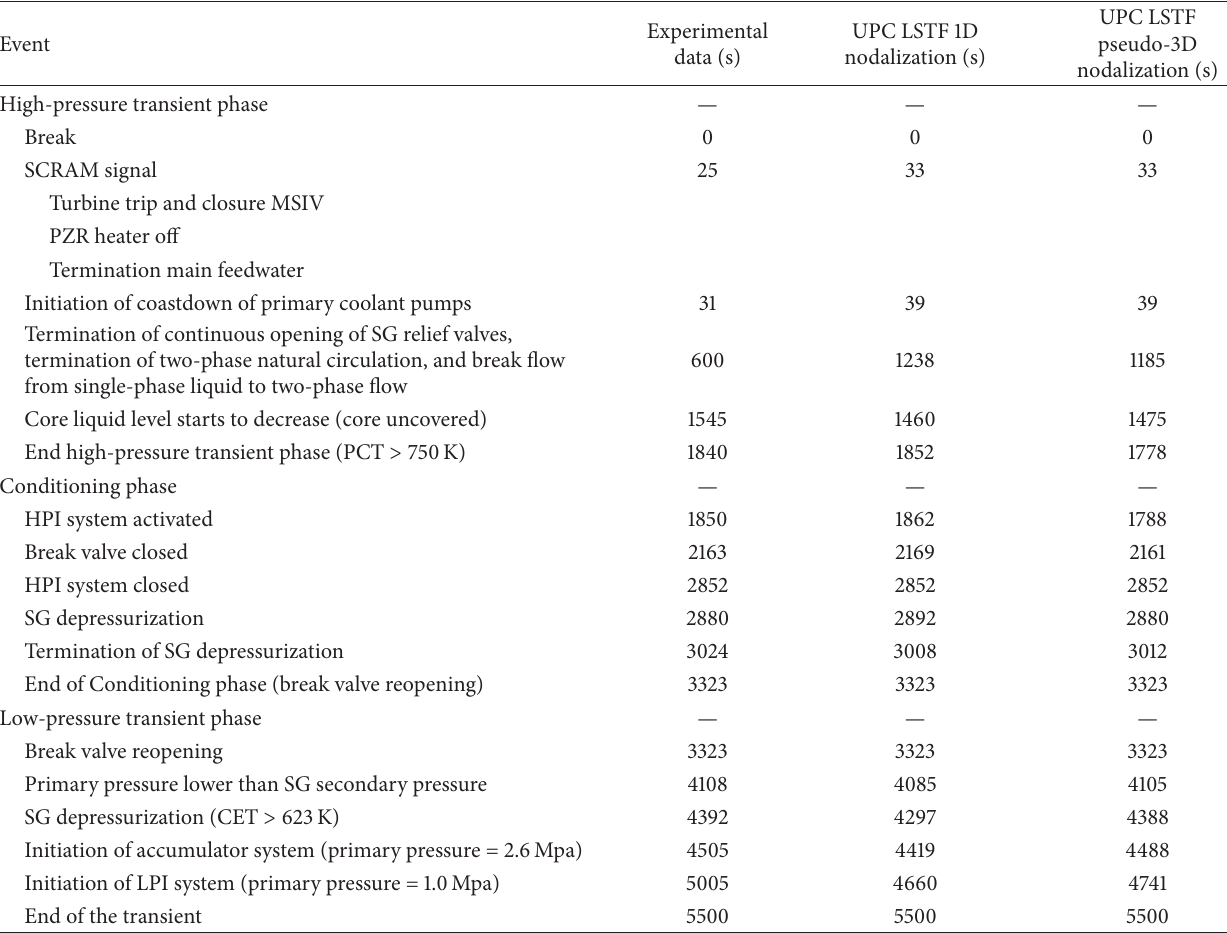
Table 6: Main events of LSTF Test